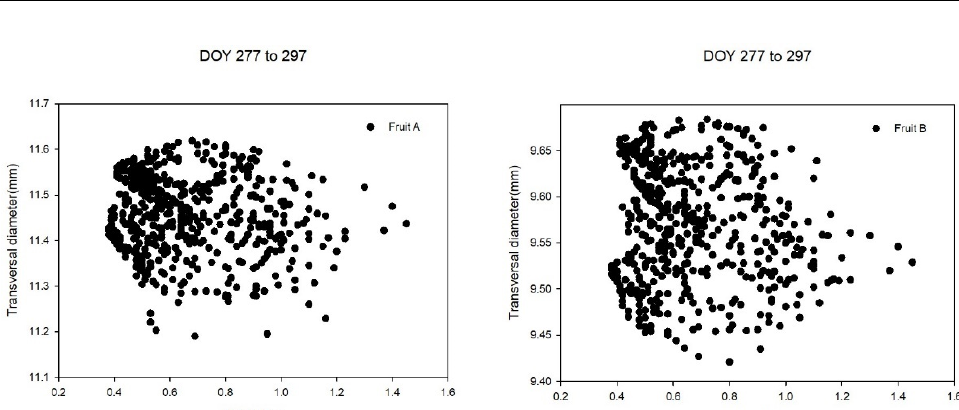
Figure 9. Transversal diameter versus VPD in all days of the second period of the experiment. Additionally, the magnitude of hysteresis loops changed and became more com- Table 1. VPD raw data. DOY 218 was beginning of experiment. So, the percentage of changing VPD in comparison with pact during the experiment, flattening along the VPD axes, due to a reduction of VPD the same measured the day before (VPD daily variation) was exclude from table. (Figure 10). Normalized graphs (Figure 10) show that the trend of transversal diameter ver- sus VPD in the first period of the experiment was different from the second period. In both time intervals in the first period (i.e., 219–252 and 253–276 DOYs), maximum transversal diameter almost occurred at the minimum range of VPD, however, in the second period this trend was not